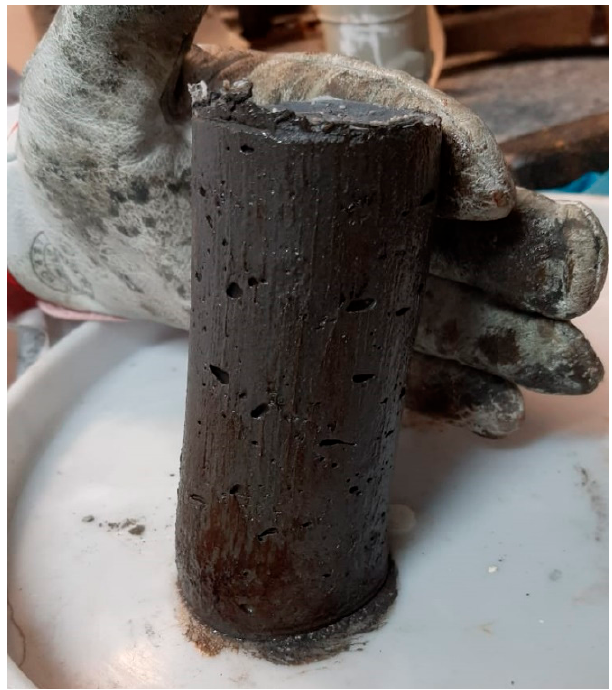
Figure 14. Consistency of Method VI with water/solids ratio of 20%, 1 day at 60 °C.